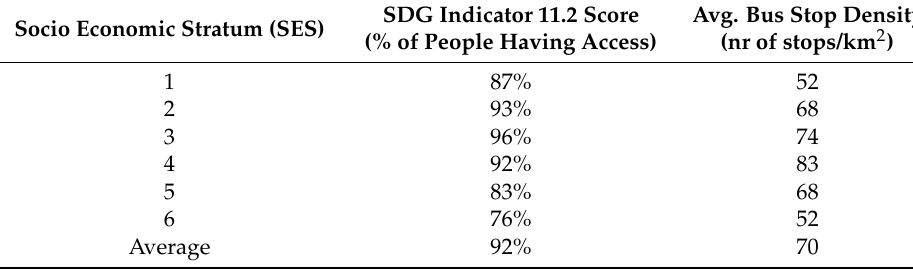
Table 3. Quantification of SDG indicator 11.2 per socio-economic stratum. Socio Economic Stratum